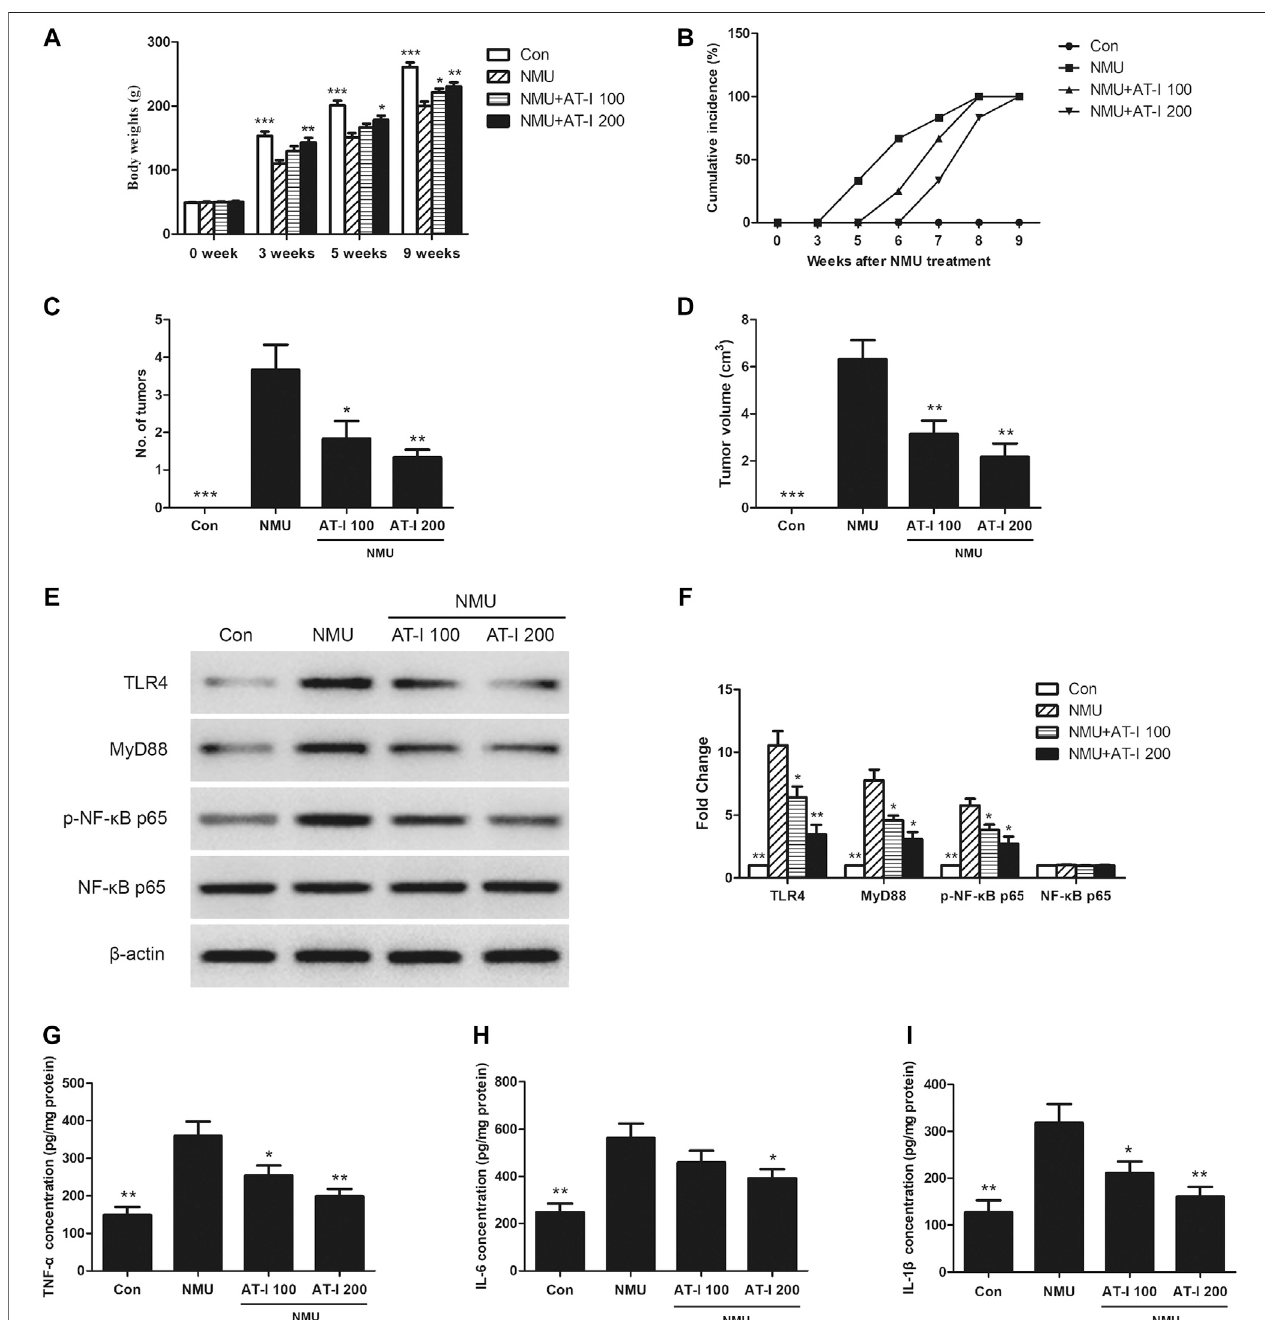
FIGURE 7 | AT-I inhibited NMU-induced rat breast cancer. The NMU-induced rats were treated with control or AT-I for 9 weeks. (A) Body weights of rats in all groups at 0, 3, 5and 9 weeks. (B) Palpable tumor incidence was recorded everyweek. (C) Average tumor number at 9 week. (D) Average tumor volume at 9 week. (E, F) Ratbreasttissueswerekepttodetect TLR4/NF- κ Bpathway bywesternblotassayat theend ofexperiment. (G, H,I) TNF- α ,IL-6andIL-1 β levelsinratbreasttissues were analyzed by ELISA at the end of experiment. Signi fi cant differences between different groups were indicated as * p < 0.05, ** p < 0.01, *** p < 0.001, vs. the NMU group, n (cid:1)